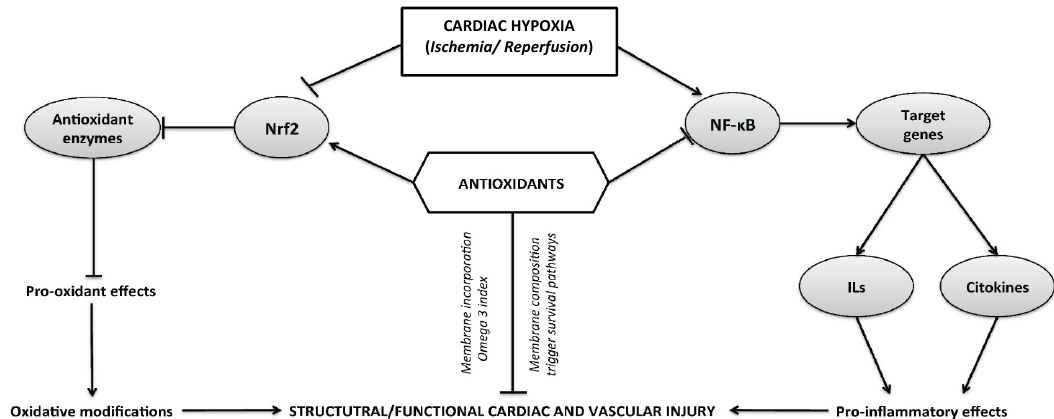
Figure 1. Representation of the cellular and molecular pathways of damage induced following a time course of hypoxia and ischemia–reperfusion cycle in different tissues. The activation of enzymatic and non-enzymatic sources of reactive oxygen species (ROS) is associated with the modulation of redox-sensitive transcriptional factors, such as the activation of nuclear factor (NF)- κ B and inhibition of nuclear factor erythroid 2—related factor 2 (Nrf2). Both cellular pathways are implicated in the oxidative modifications or pro-inflammatory effects that can mediate structural or functional cardiovascular